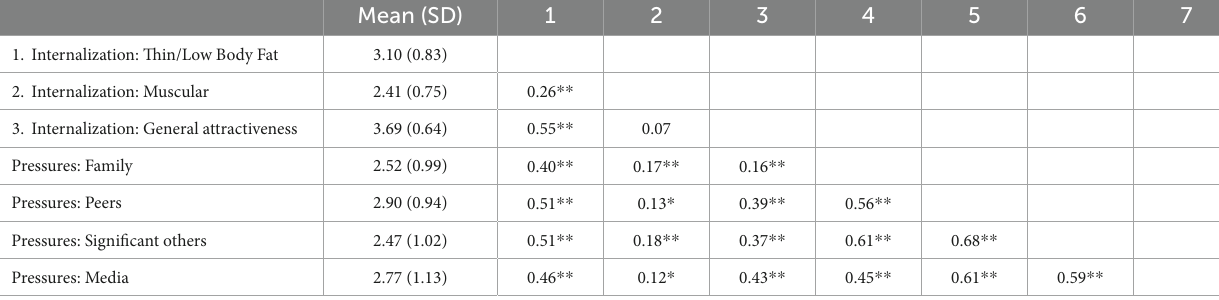
TABLE 3 Means and inter-correlations between the Chinese SATAQ-4R Male Subscales ( N =